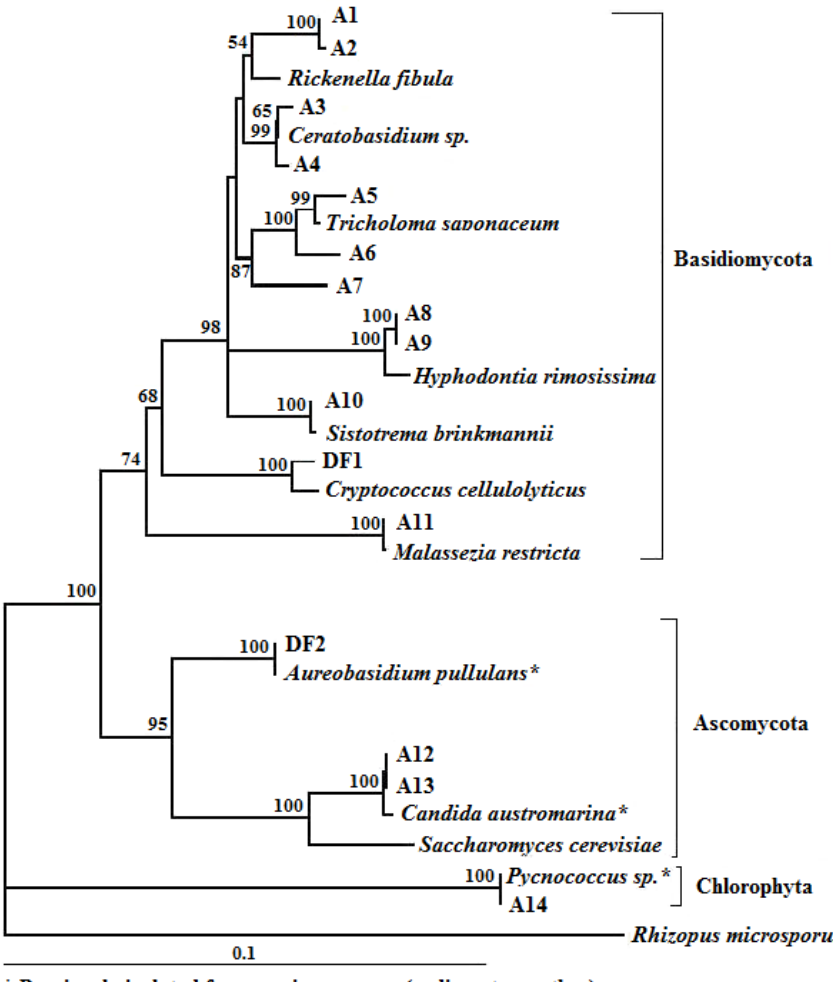
Fig. 2. A neighbor joining tree shows the phylogenetic relationships among our 18S rRNA environmental clones, plate isolates, and their top sequence matches obtained through NCBI BLAST. The distance tree is based on a sequence alignment spanning over a 1.138 nucleotide region of the 18S rRNA gene and is rooted with R. microsporus . The distances were calculated using the HKY85 nucleotide model. The bootstrap analysis was done using